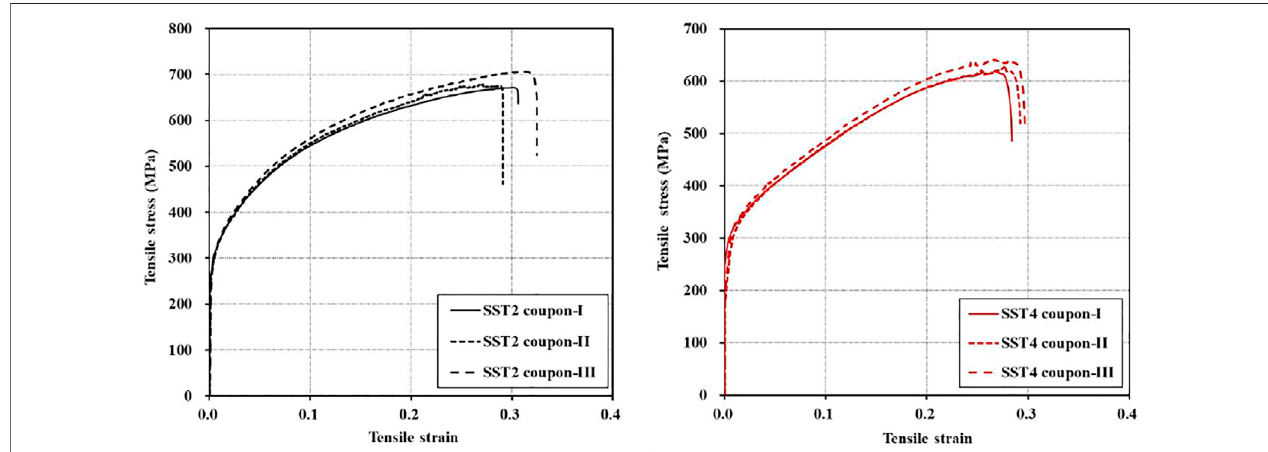
FIGURE 1 | Test curves of stainless steel tube coupons.